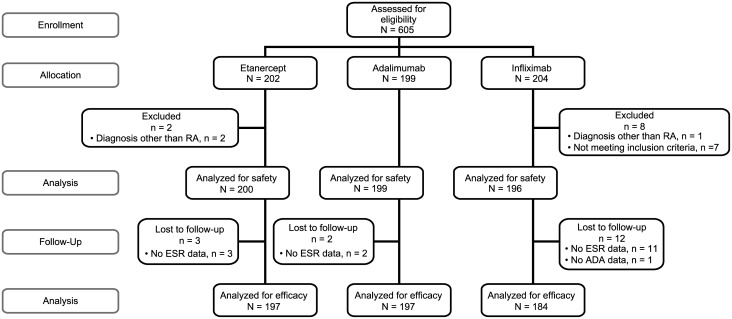
Patient disposition.